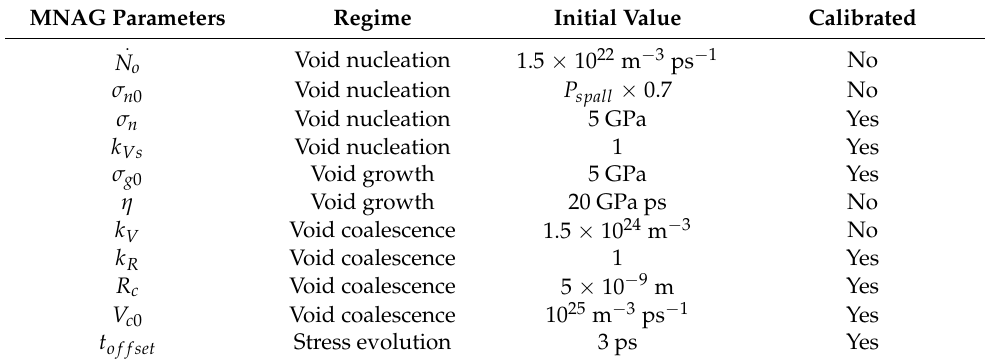
Table 1. The initial parameters in the MNAG model obtained from shock simulations of single crystal Ta.